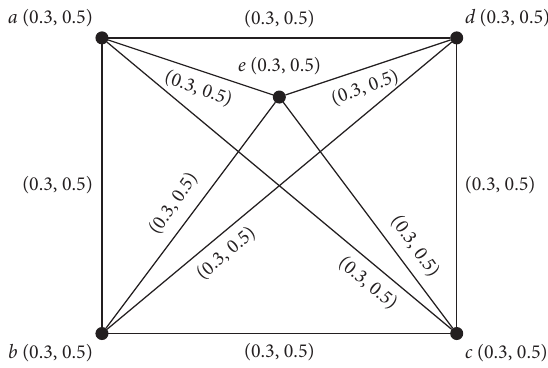
Figure 7: A VG G